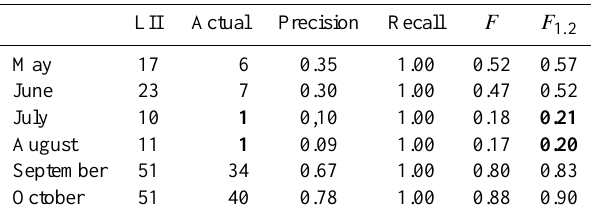
Table 3. LII: monthly performance for the period 1 June 2008